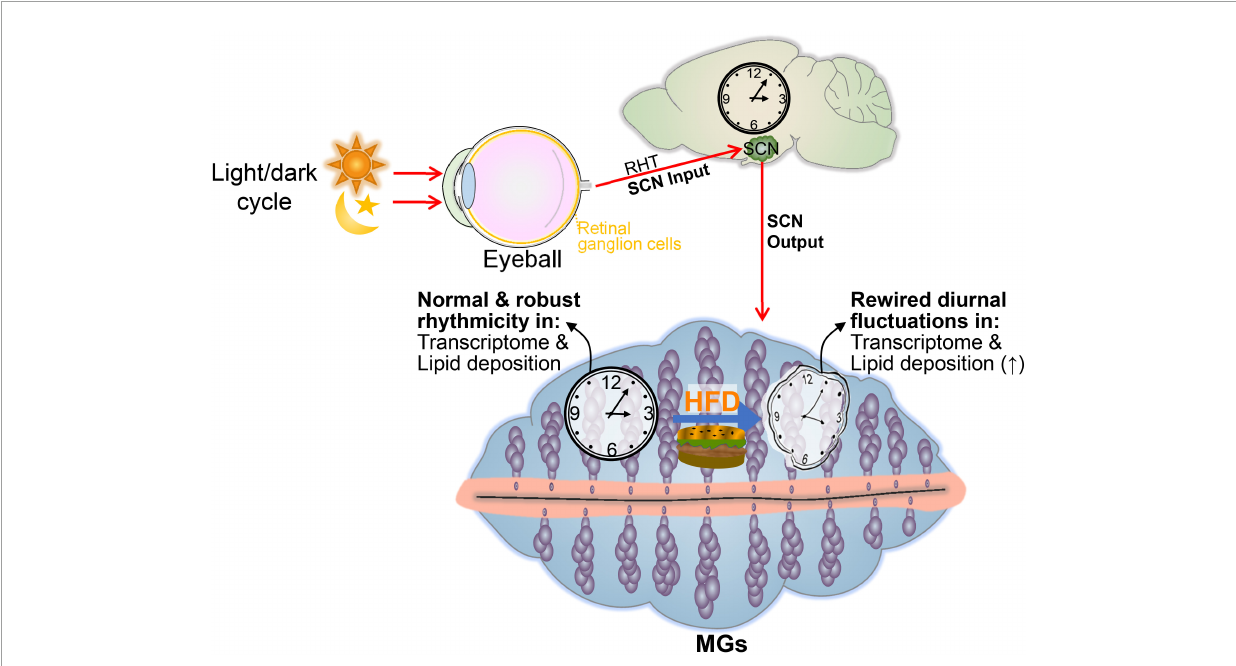
FIGURE7 Summary displaying the effects of an HFD on the cyclical transcriptomic profile of MGs. In mice receiving a high-fat dietary regimen, the light-regulated central clock pacemaker (SCN) functions normally and expresses normal sleep/wake and fasting/feeding rhythms. However, a high-fat diet alters the normal circadian rhythmicity transcriptome profiles and lipid droplet oscillation of